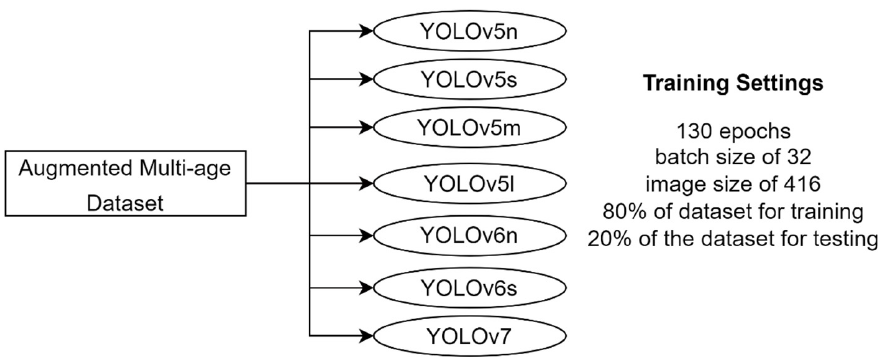
Figure 9. Training settings for the augmented multi ‐ age dataset: different YOLO models trained with 130 epochs, a batch size of 32, an image size of 416, and an 80–20% train ‐ test